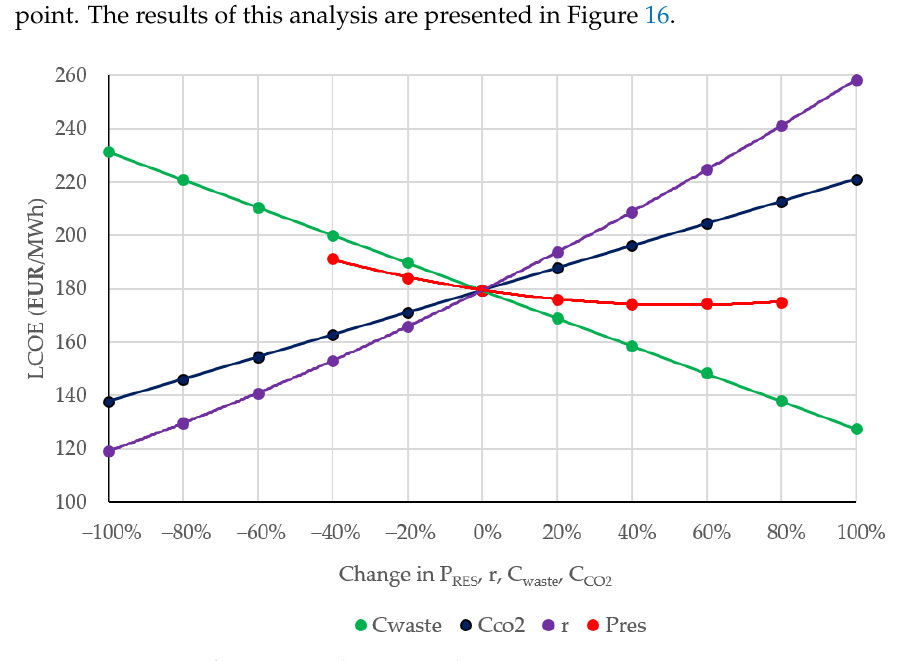
Figure 16. Impact of parameter changes on the LCOE. The results indicate that in the variant where RES equals 10 MW, the LCOE is 176.5 EUR/MWh. Comparing the results with the current state of knowledge, it is much less than in the study by Bagheri et al. [39], where a system including PV, batteries, WT and a biomass gas generator had an LCOE of 300 – 370 USD/MWh. In addition, 176.5 USD/MWh is more than 2.5 times less than the result obtained by Samy and Barakat when examining a system consisting of biomass gasification, PV sources and a battery system [82]. They also found that the battery cost was 52.3% of the total cost. In the study by El-Sattar et al. [36], which examined a HGS consisting of PV, WT, batteries and biomass gasification, the battery accounted for 43.5% of the costs, and for as much as 48.9% in the system without PV. Therefore, the system that we propose, one that does not contain batteries, has the potential to be much cheaper than systems containing this type of energy storage. Fur- thermore, the use of waste as fuel avoided fuel costs, resulting in additional profits. Simi- lar results (LCOE of 173 – 181 USD/MWh) were obtained by Singh et al. [31] for a system of PV, WT, batteries and biomass gasification. Figure 17 presents the results of the analysis of the impact of changes in the system parameters on the HGS payback period. The graph shows that the price of electricity is the most influential factor. This is due to the fact that, unlike CO 2 emissions and the price of waste, this parameter applies to all generated energy. If the price is reduced to 179 EUR/MWh, this installation is no longer profitable. On the other hand, increasing the price to 400 EUR/MWh reduces the payback time to less than 6 years. The same applies in the case of LCOE. Increasing the RES power is associated with a decrease in PP, whereas the higher the values, the smaller the de- creases. The minimum value of C waste guaranteeing a return over a period of 20 years is 44.5 EUR/Mg. The maximum cost of CO 2 emissions at which a return was possible was less than 54 EUR/Mg.